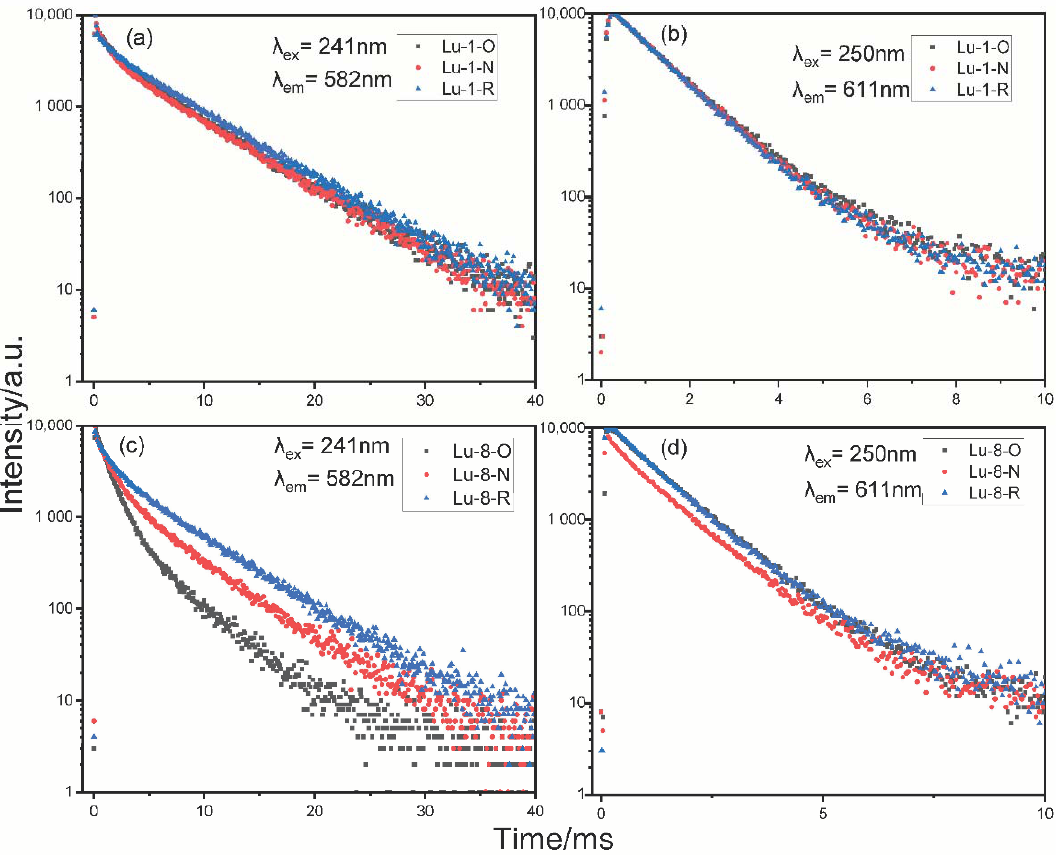
Figure 5. PL decay curves of Lu 2 O 3 :1%Eu and Lu 2 O 3 :8%Eu single crystals for ( a , c ) 582 nm emission and excitation under 241 nm, for ( b , d ) 611 nm emission and excitation under 250 nm.